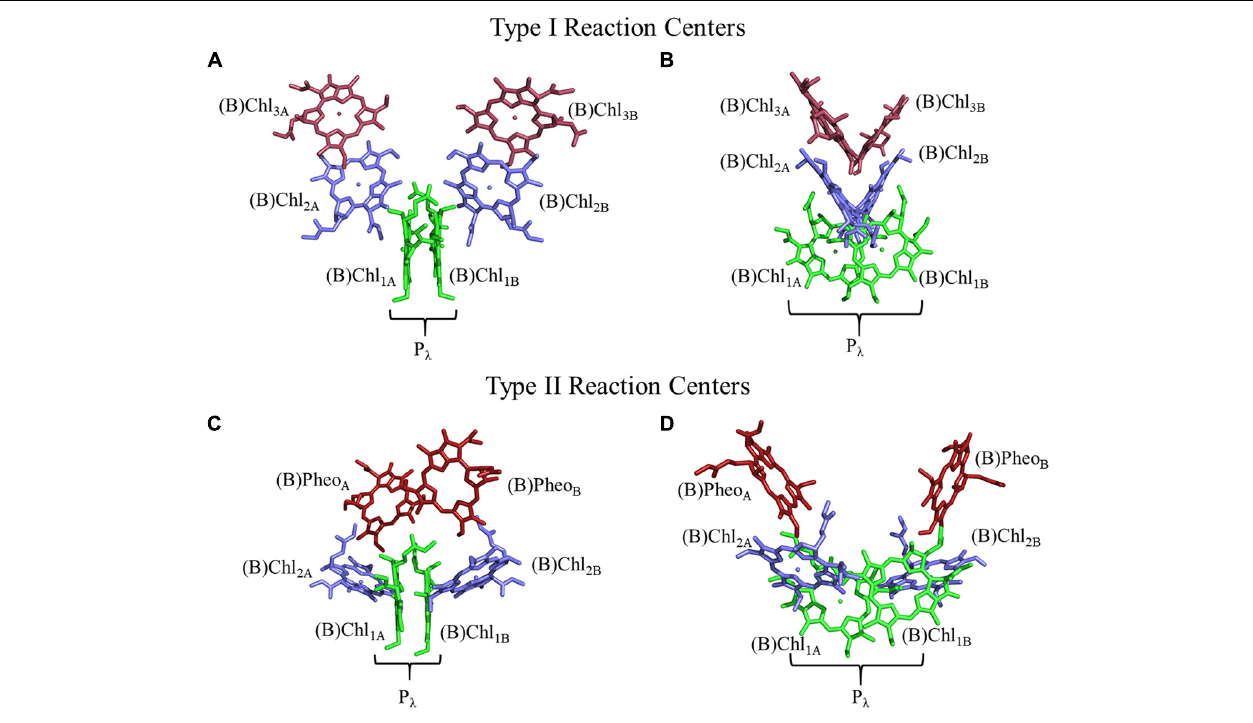
FIGURE 1 | Structure and orientation of early (B)Chl acceptors in Type I (top) and Type II (bottom) RCs viewed from different angles. (A,C) A parallel orientation of the primary donor macrocycle planes, and (B,D) a perpendicular orientation of the primary donor macrocycle planes. The (B)Chl molecules of the primary donor, (B)Chl 1 , are shown in green, (B)Chl 2 in blue, and (B)Chl 3 /(B)Pheo in red. The two (pseudo-)symmetric branches of cofactors are denoted as ‘A’ and ‘B,’ respectively.